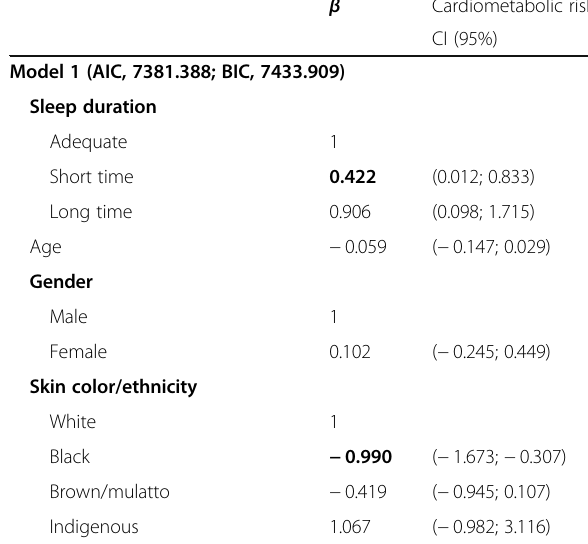
Table 2 Regression analysis between sleep duration, age, gender, and skin color/ethnicity with cardiometabolic risk in adolescents β